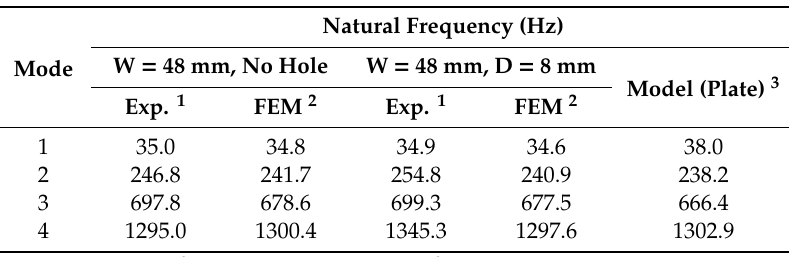
Table 6. Comparison of the natural frequency of a uniform composite rectangular cantilever plate (W = 48 mm) with experimental and FEM results for samples of the same width.